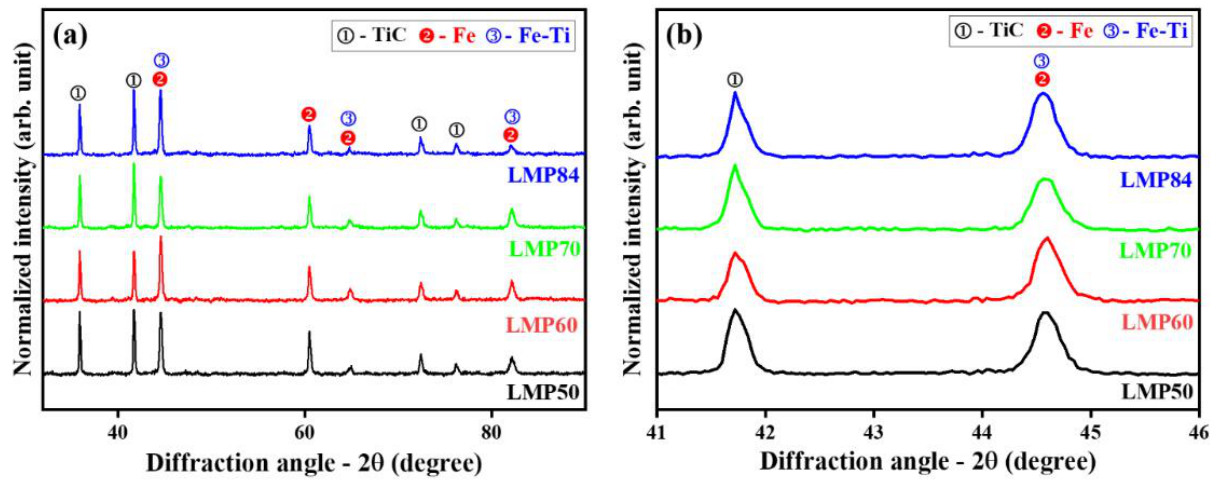
Figure 4. X-ray diffraction patterns of TiC-based cermets ( a ) as-built parts with different laser melting peak power processed through selective laser melting and ( b ) magnified view of the peaks.